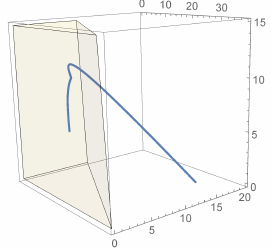
Figure 3. Trajectory solution that reaches the polytope P ¯ N and remains within it from the parameters values given in the example of Section 4.1.